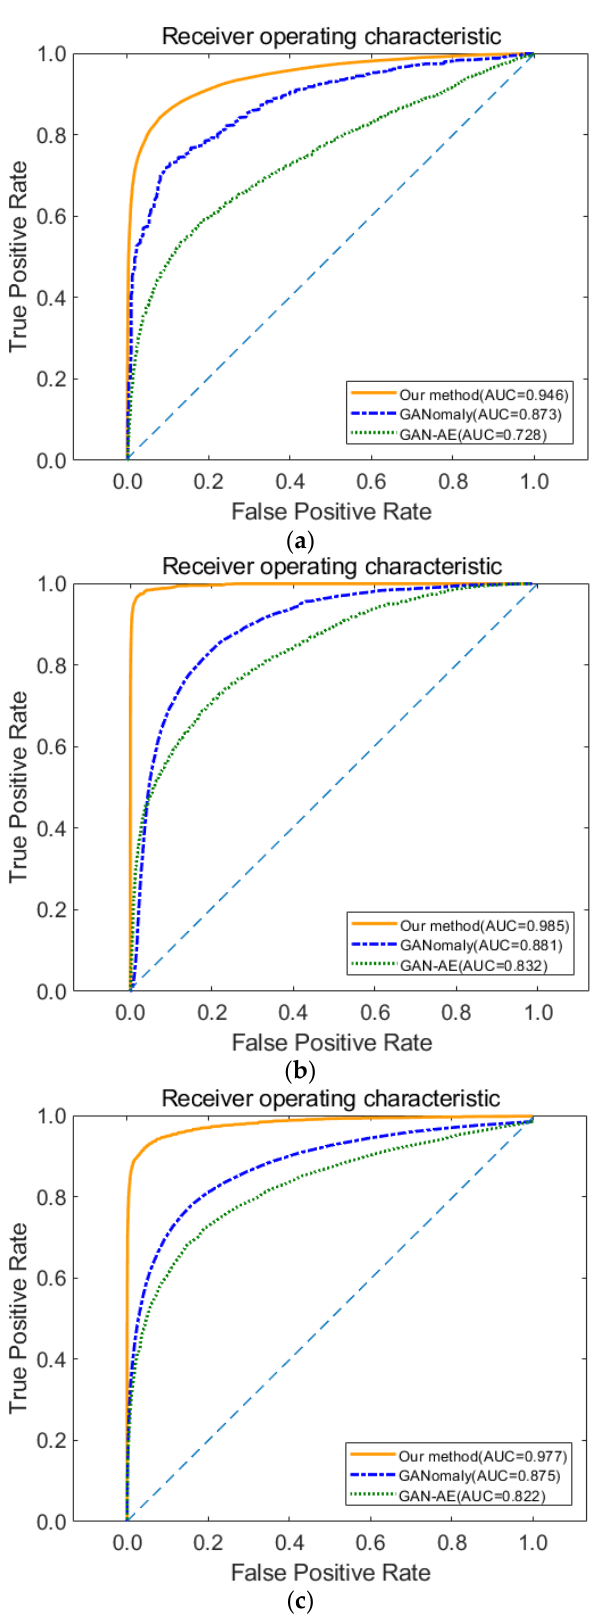
Figure 12. ROC curves of three methods under three input conditions: ( a ) Case1; ( b ) Case2; ( c ) Case3.